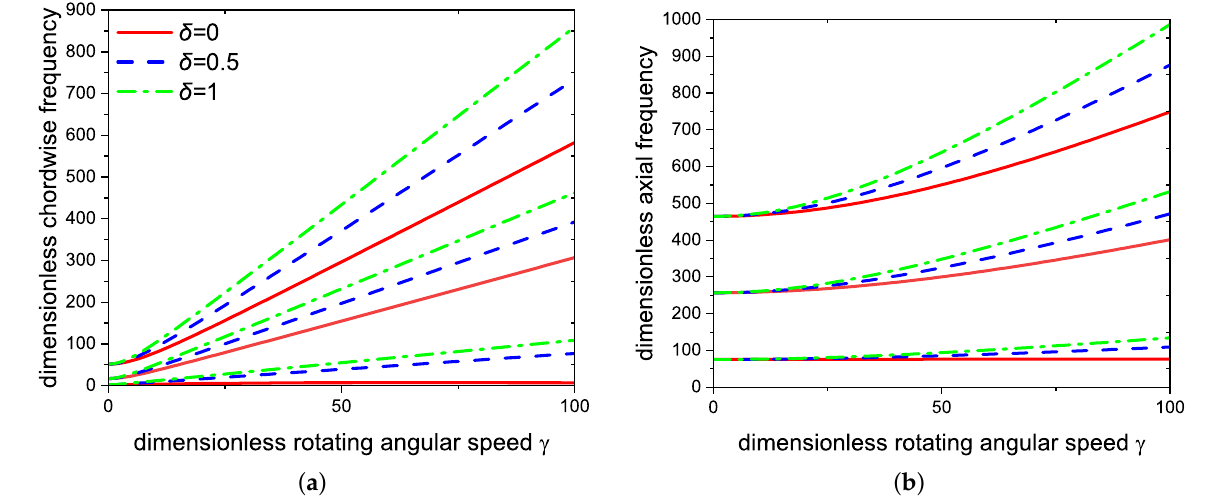
Figure 11. The first three-order dimensionless frequencies of rotating cantilever beams with different center body radius ratios δ = 0, 0.5, and 1: ( a ) Chordwise frequency; ( b ) Axial frequency.